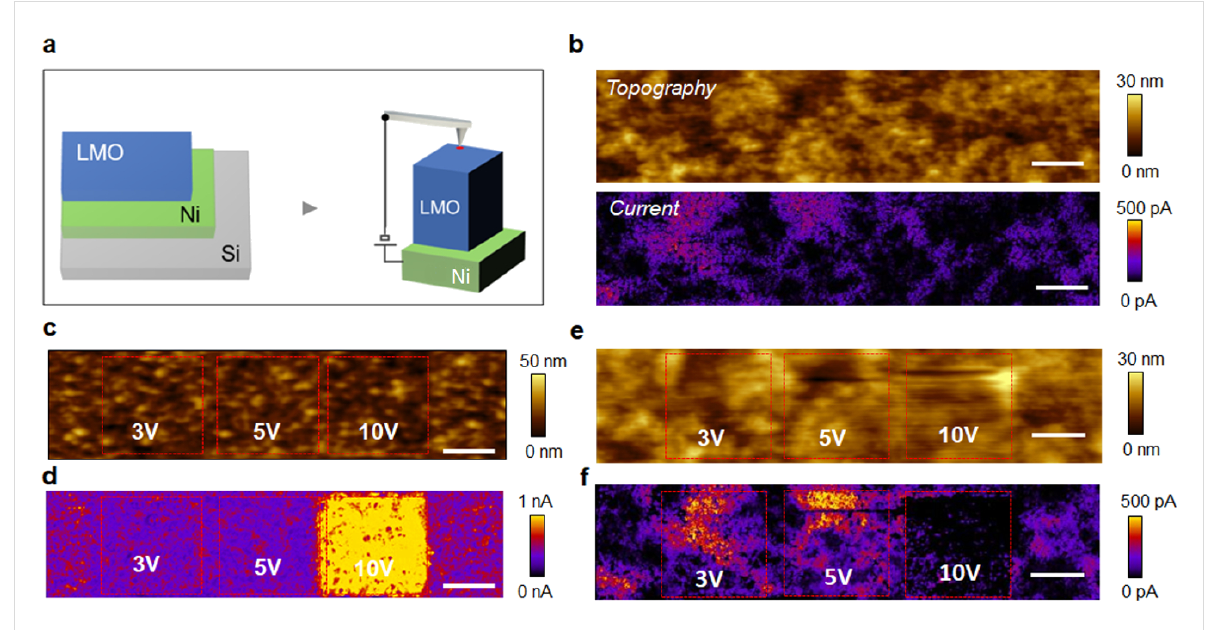
Figure 1: C-AFM configuration and study of the influence of an applied voltage stress on MnO 2 and LMO. (a) Schematic of the C-AFM setup and sample structure. The tip is grounded while the dc bias is applied to the sample. (b) Topography and current maps as collected by C-AFM on the elec- trodeposited LMO sample applying 1.5 V. (c) MnO 2 morphology and (d) current map reporting three areas previously stressed at different dc bias values applying 1.5 V. (e) Electrodeposited LMO morphology and (f) current map reporting three areas previously stressed at different dc bias values applying 1.5 V (scale bar 1 µm for all